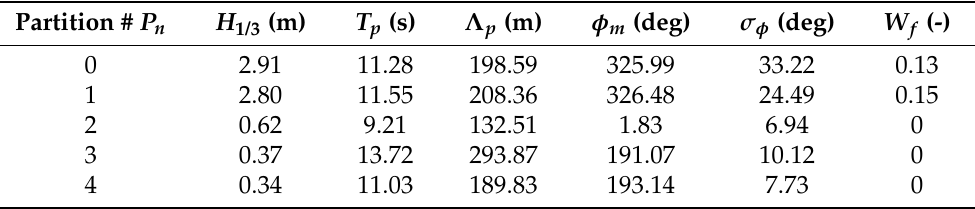
Table 2. An example of partitioned spectrum data. Total wavefield, wind-sea and swell-sea informa- tion are provided by partitions 0, 1, and 2–4, respectively. For each partition, H 1/3 : total significant wave height in meters; T p : peak period in seconds; Λ p : wavelength at peak period; φ m : mean wave direction at peak period in degrees; σ φ : spectral width in degrees; and W f : wind-sea